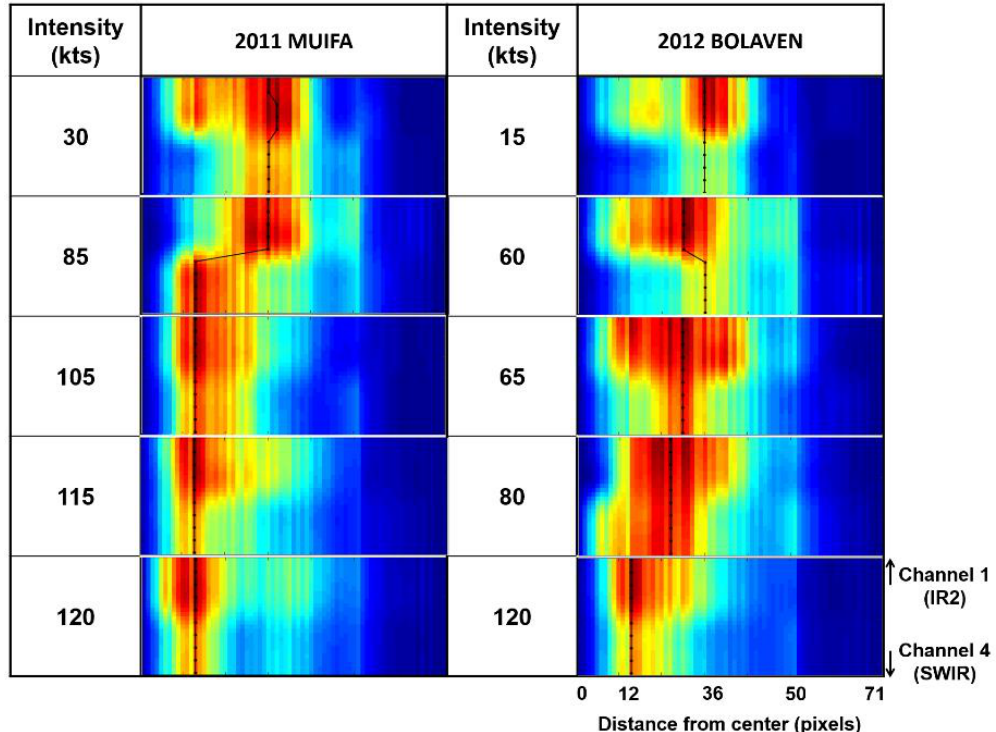
Figure 13. The integrated heat maps of validation typhoon cases—typhoon MUIFA in 2011 and typhoon BOLAVEN in 2012. The highest heat map values of each row are marked and connected using black lines. The stronger TC has a high heat map value near the center in the lower layer.